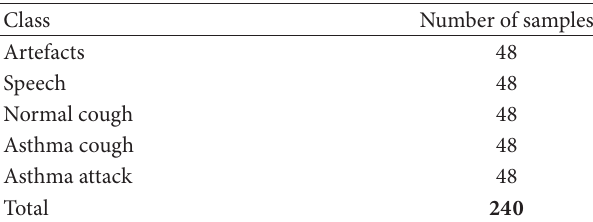
Figure 7: Probability of correct classification in AWGN channel versus SNR; ∗ SVM and ∘ HMM. Table 3: Sound signals used in generating the training set of the classifier.